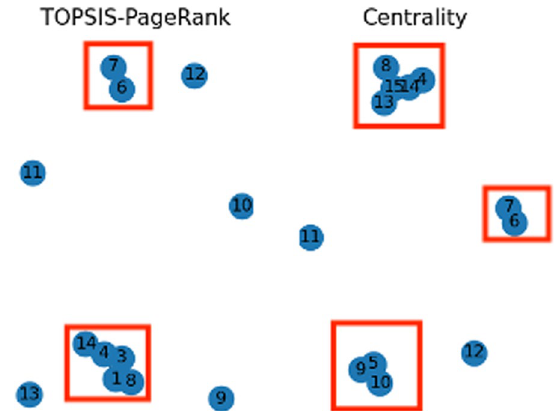
Fig. 2 TOP 3 nodes attack connectivity comparison figure a